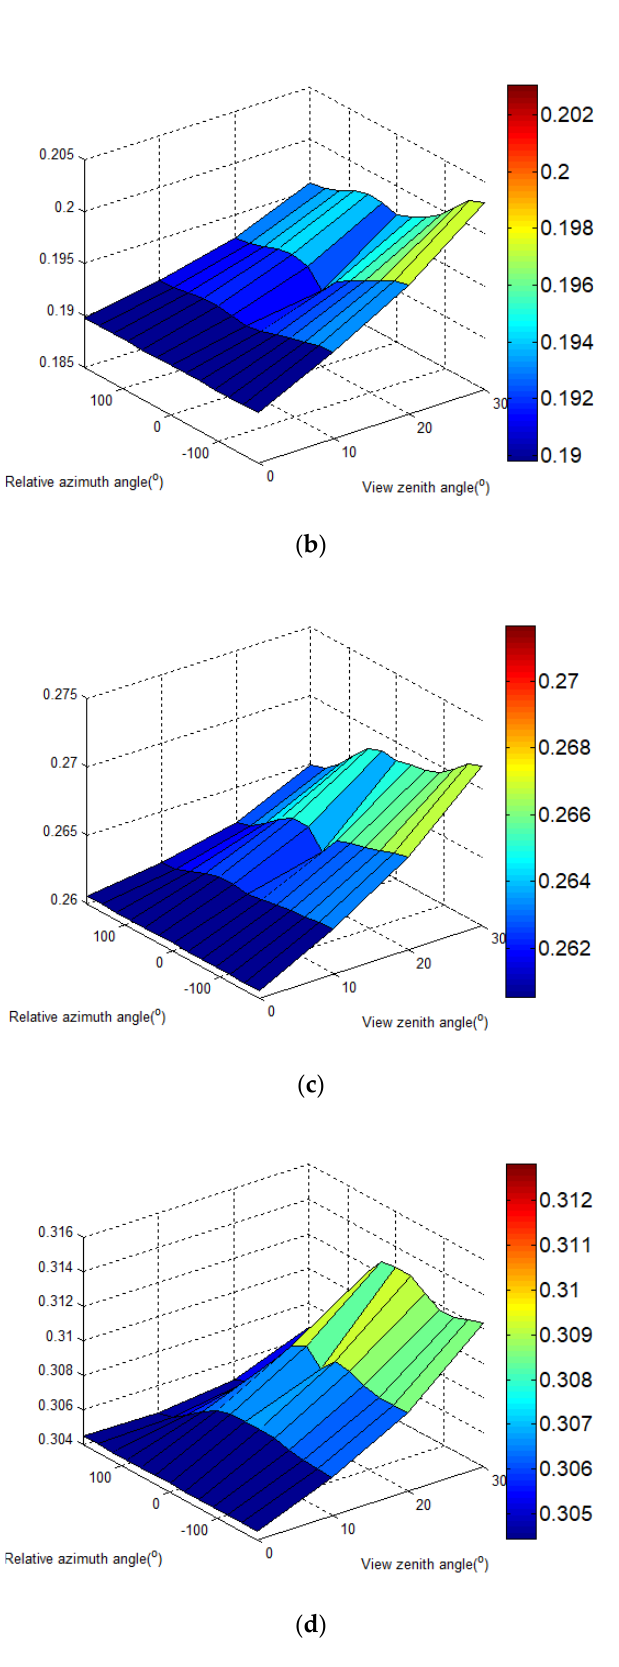
Figure 5. Surface bidirectional reflectance factor of the desert target. ( a ) Band 2; ( b ) band 3; ( c ) band 4; ( d ) band 8.